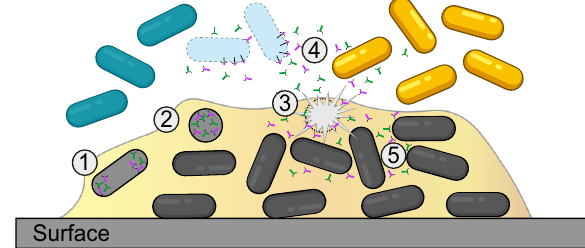
Fig. 8 Model of the ecological role of R-tailocins in interbacterial competitiveness. We propose a model where R-tailocins play an important ecological role within a bacterial community such as the ones that compose bio fi lms. 1 Some cells are induced upon environmental stress and synthesize R-tailocins that are produced at the center of the cell and migrate to the cell poles. 2 Subsequently to the migration of the R-tailocins, the cells lyses, fi rstly by forming a spheroblast. 3 Secondly, the cell lyses completely and explosively, thereby thrusting its R-tailocins in the environment. 4 Once in the medium, R-tailocins speci fi cally bind to kin bacteria and kill them whereas more distantly-related bacteria are spared. 5 Clonal cells are immune and are therefore protected from the R-tailocins released in the